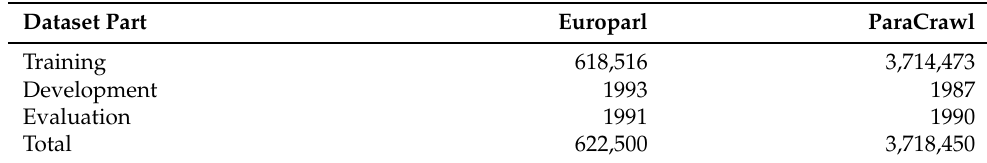
Table 1. Number of segments (sentences) in each